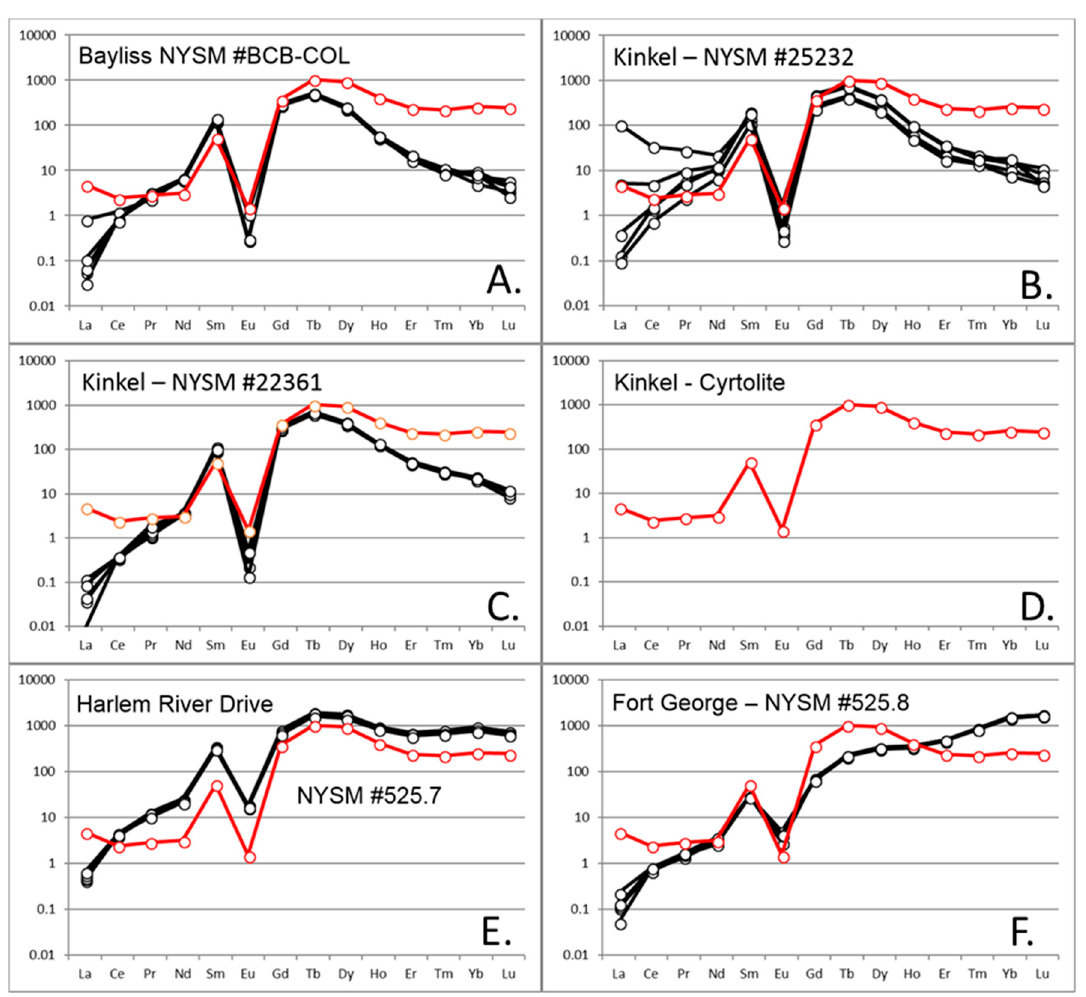
Figure 6. Chondrite-normalized rare earth element plots for columbite samples analyzed: ( A ) Baylis (NYSM #BCB-COL); ( B ) Kinkel (NYSM #25232); ( C ) Kinkel (NYSM #22361); ( D ) Kinkel (Cyrtolite); ( E ) Harlem River Drive (NYSM #525.7); and ( F ) Fort George (NYSM #525.8). Red line on each diagram is average REE concentrations for Kinkel cyrtolite for comparison.